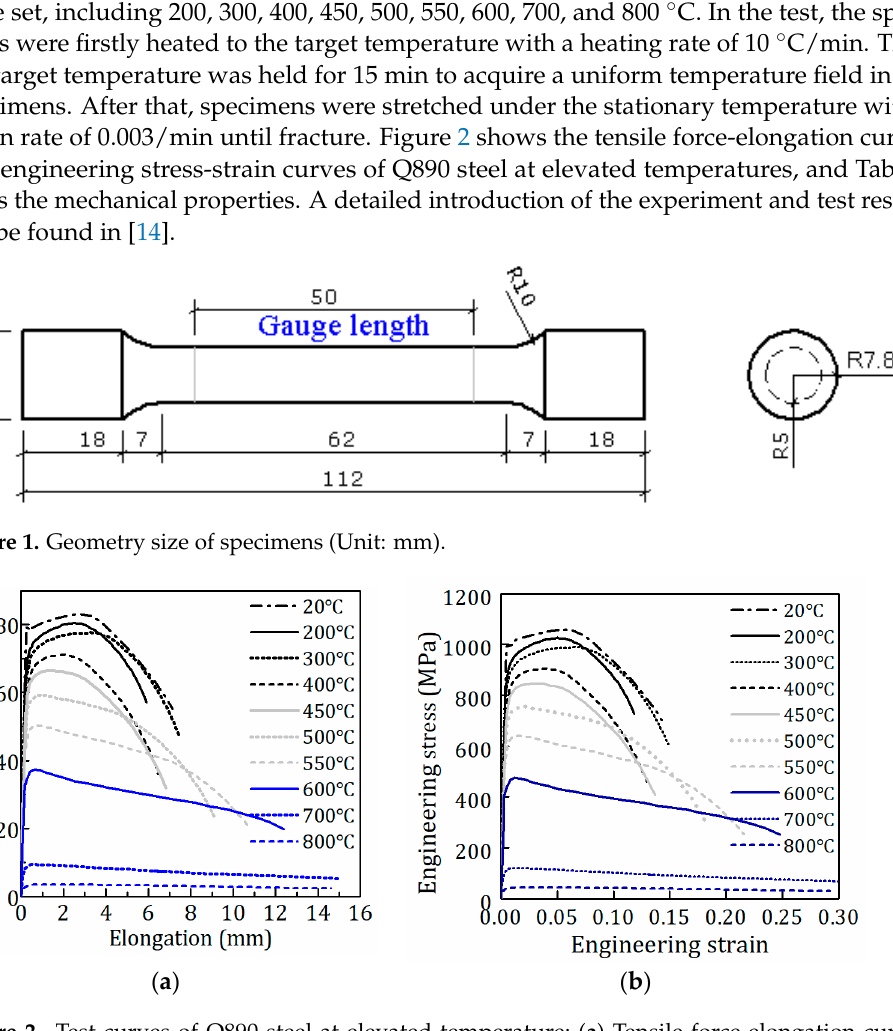
Figure 2. Test curves of Q890 steel at elevated temperature: ( a ) Tensile force-elongation curves; ( b ) Engineering stress-strain curves. Table 1. Mechanical properties of Q890 high-strength steel at elevated temperature.